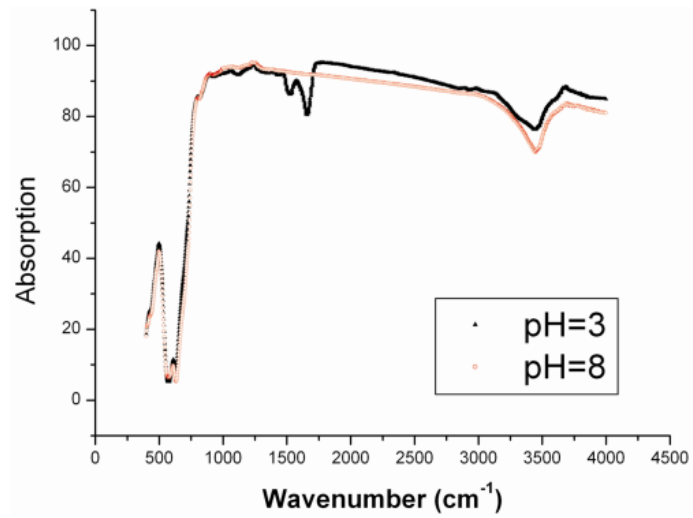
Figure 4. The IR spectra of nanoparticles after centrifugal separation of BSA and γ -Fe mixture under acidic and basic conditions,